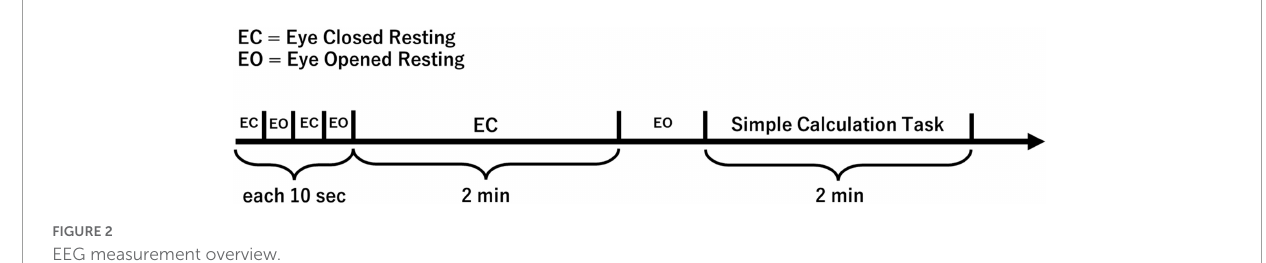
FIGURE2 EEG measurement